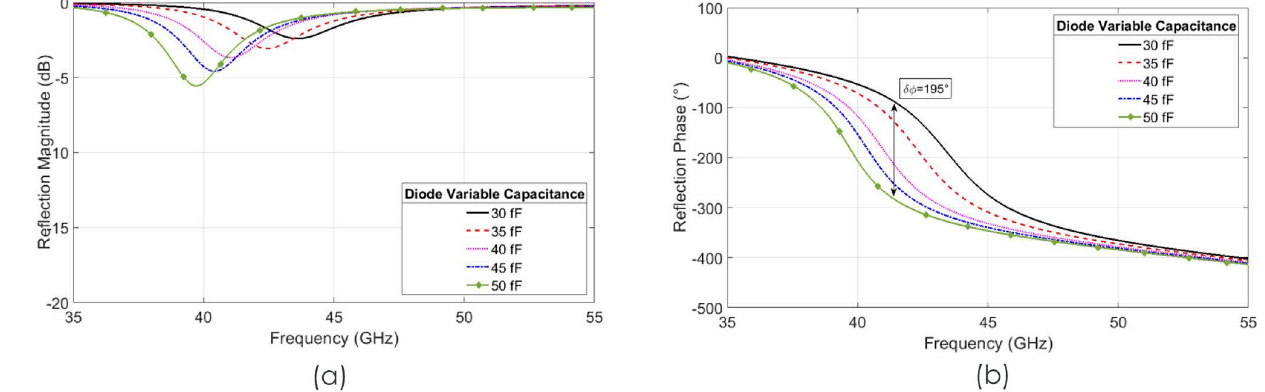
Figure 2. Simulation results of the proposed periodic unit cell array. ( a ) Reflection magnitude simulation results with varying junction capacitance. ( b ) Reflection phase simulation results of the unit cell with varying junction capacitance.